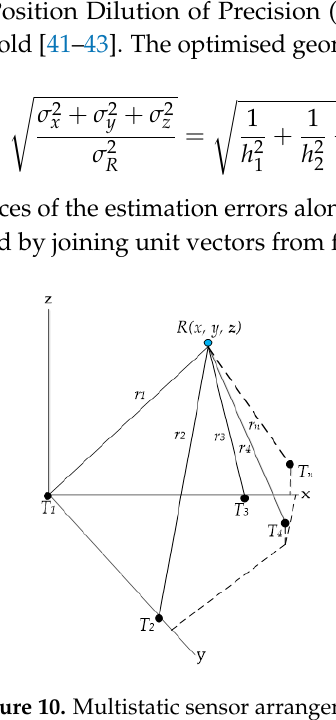
Figure 10. Multistatic sensor